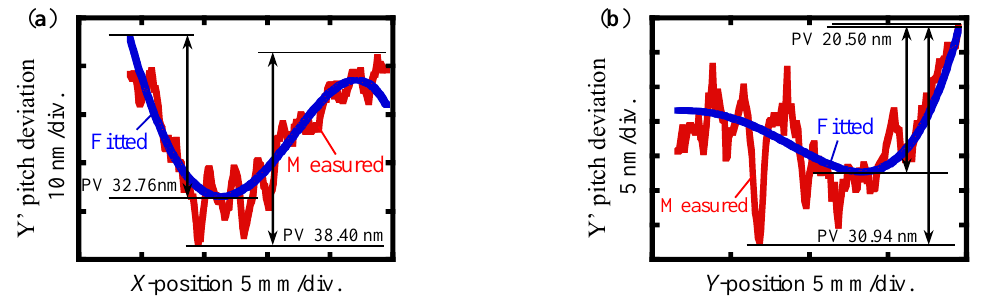
Figure 10. Central cross-sections of the Y ′ -directional pitch deviation shown in Figure 9. ( a ) Central cross-section along the X -direction; ( b ) Central cross-section along the Y -direction.